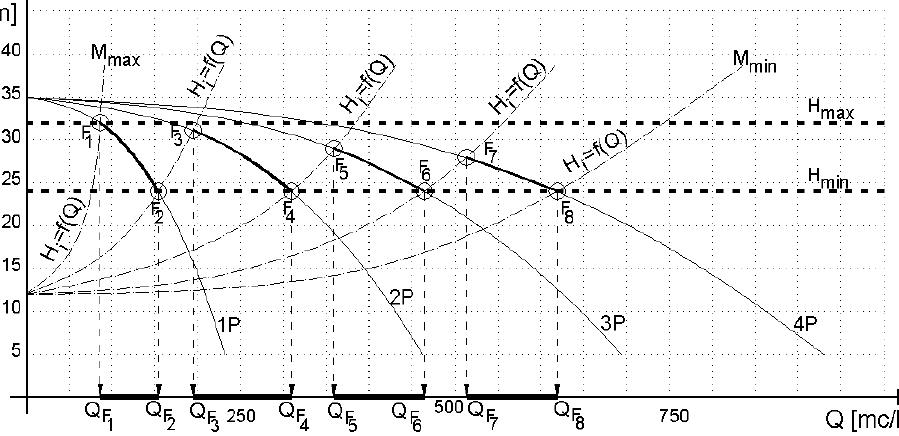
Figure 1. Sequential adjustment for a pumping stations when the water demand is